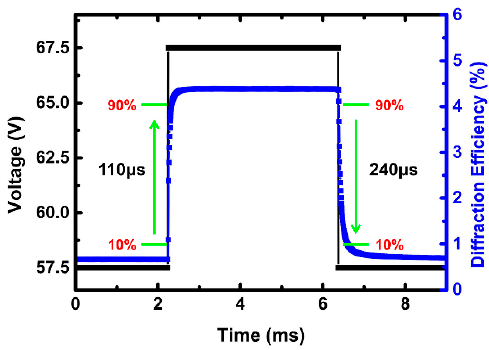
Figure 5. Plots the electro-optical response of rise time and decay time of the liquid crystal (LC) grating on first order.